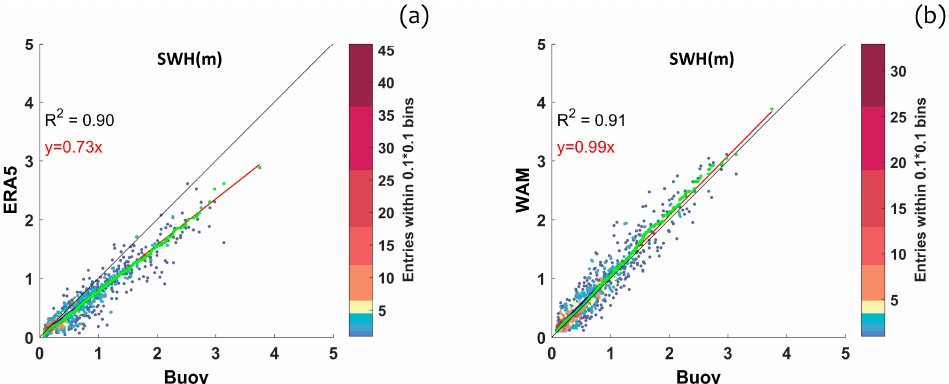
Figure 5. Dataset 1 January 2006–31 December 2006, time step of 6 h. Comparison of SWH ERA5 ( a ) and WAM ( b ) hindcast datasets to buoy data at Cetraro. Green lines represent the quantile–quantile plots, black lines the bisector, and red lines the least-square best